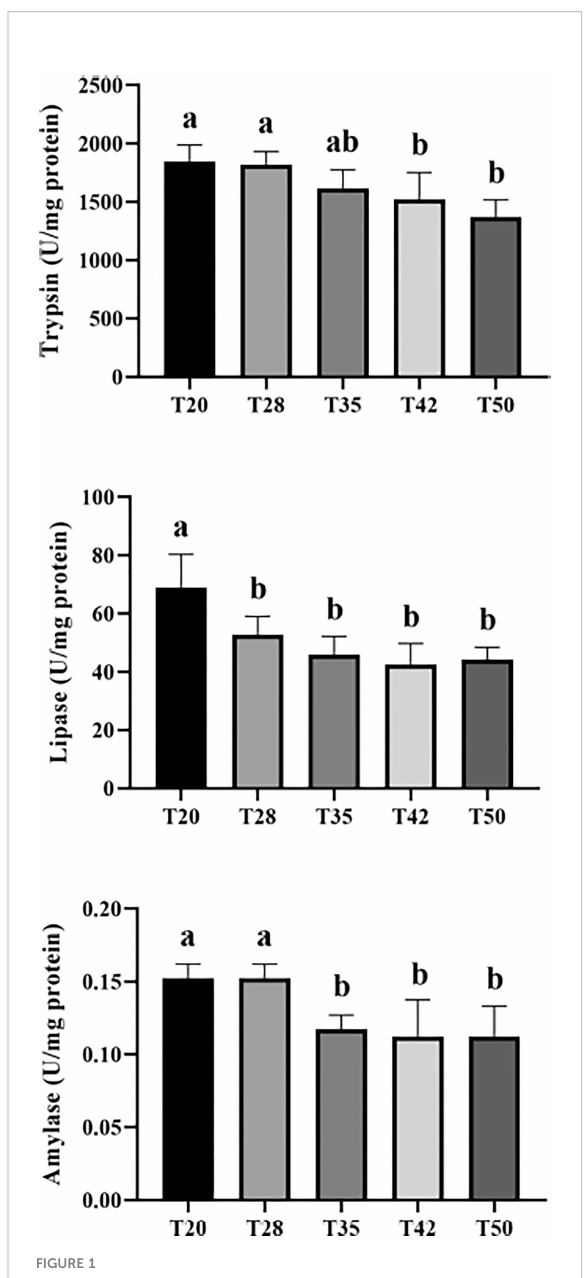
FIGURE 1 Intestinal digestive enzyme activities of L. vannamei fed with experimental diets. Different letters above the bars denote signi fi cant differences among diets (p < 0.05). T20 – T50, diets containing 20% – 50% of soybean